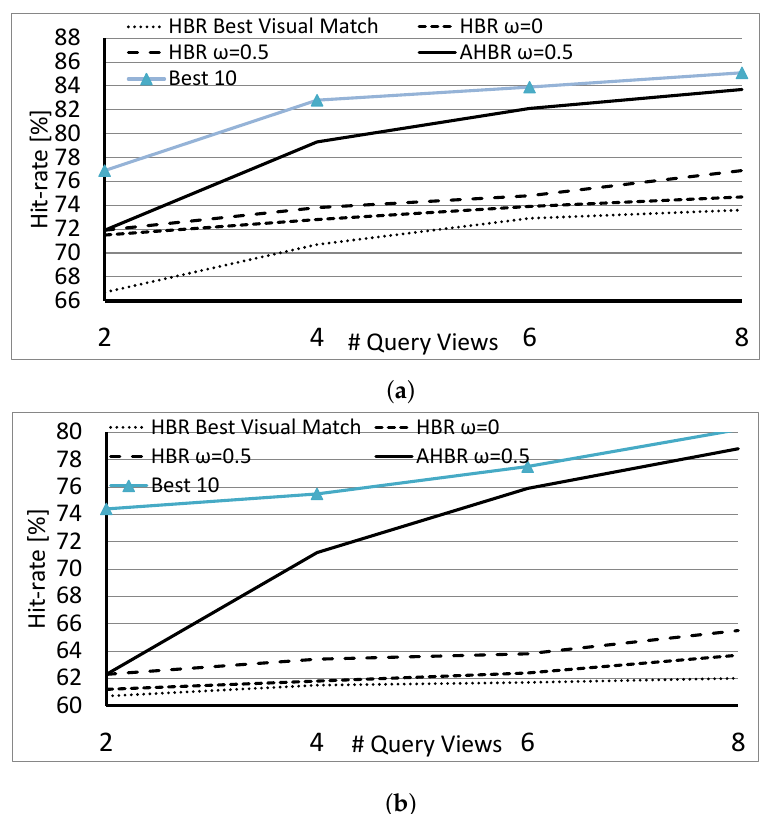
Figure 6. Average hit-rate obtained over the COIL-100 dataset with the HBR Best Visual Match, the HBR ω = 0.0, ω = 0.5, the AHBR ω = 0.5, and with the “Best 10”: ( a ) queries with motion blur ( top) ; ( b ) queries with additive Gaussian noise ( bottom